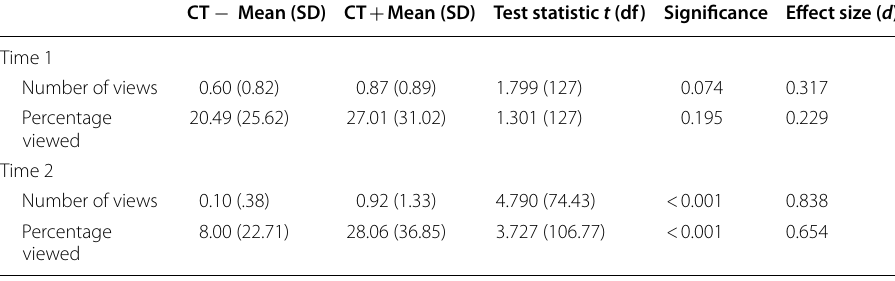
Table 1 The impact on transcript availability on video views and percentage viewed